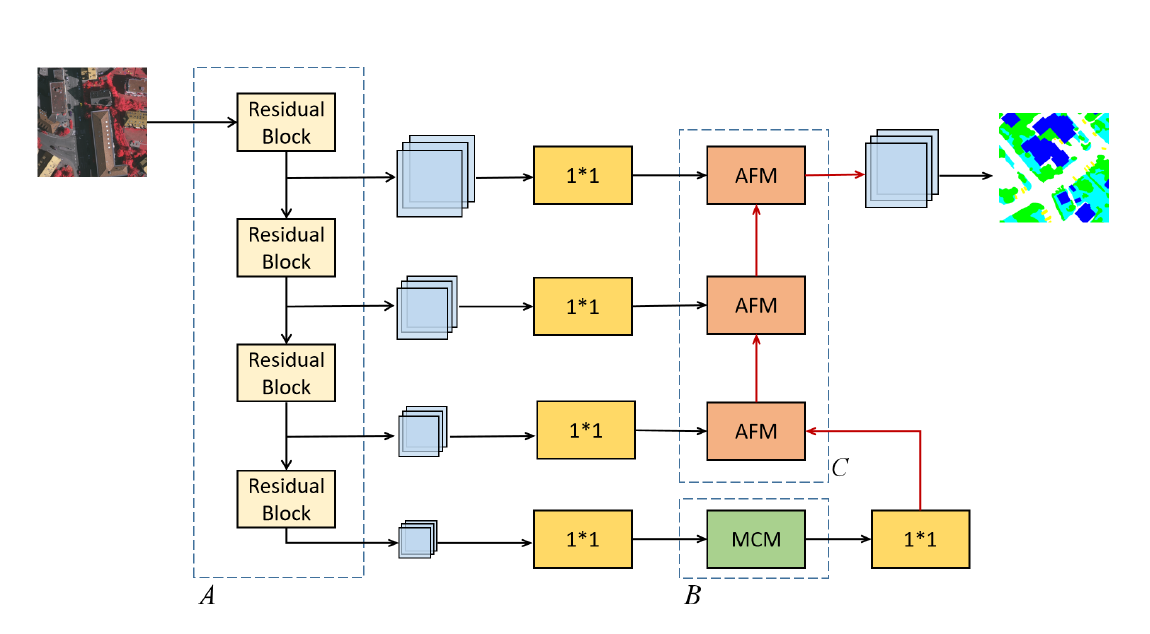
Figure 3. The overall structure of the proposed multi-scale adaptive feature fusion network (MANet). Part A is the backbone network. Part B is a multi-scale context extraction module. Part C is a high- level and low-level feature adaptive fusion